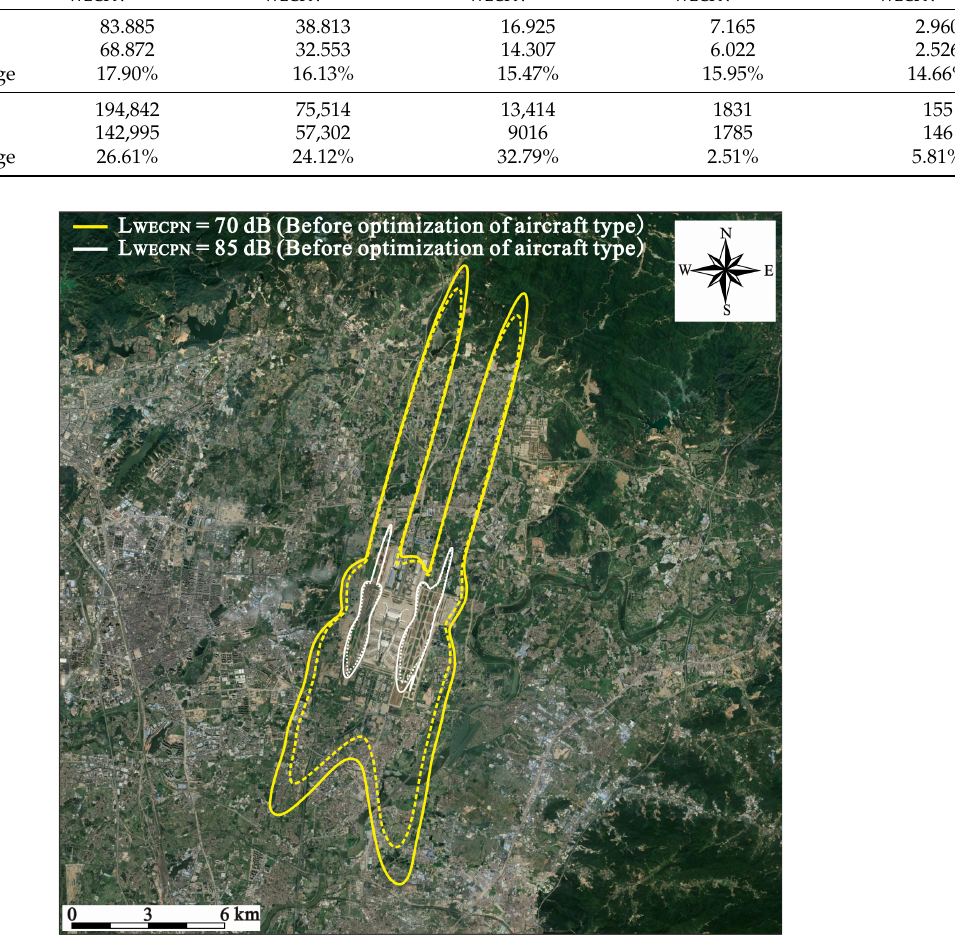
Figure 3. Noise contours before and after using the low-noise aircraft type during